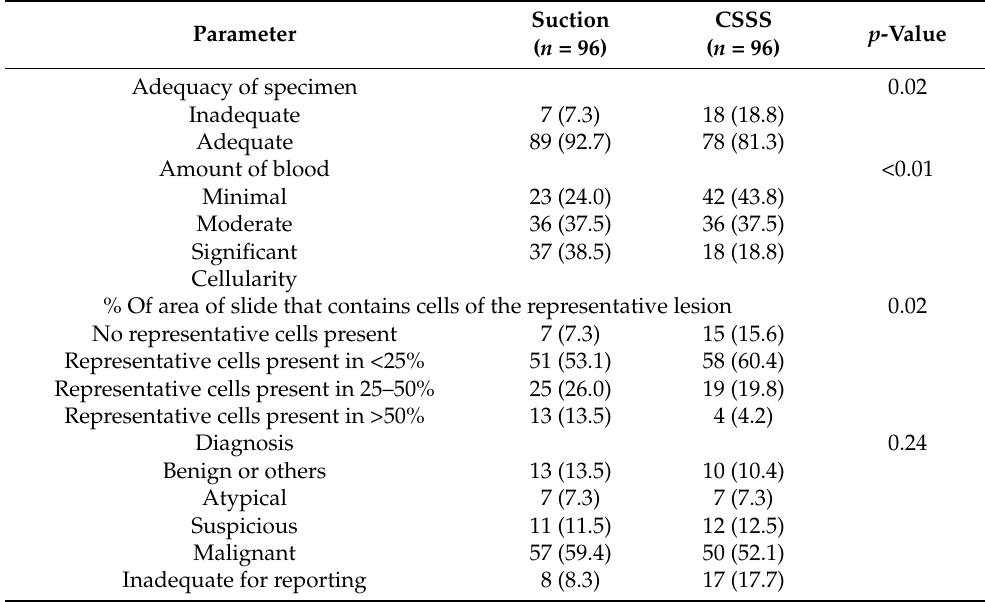
Table 6. Cytological results of samples that were obtained with suction or capillary sampling with stylet slow-pull (CSSS) in the same lesion using the optimal number of actuations (per needle passes, study